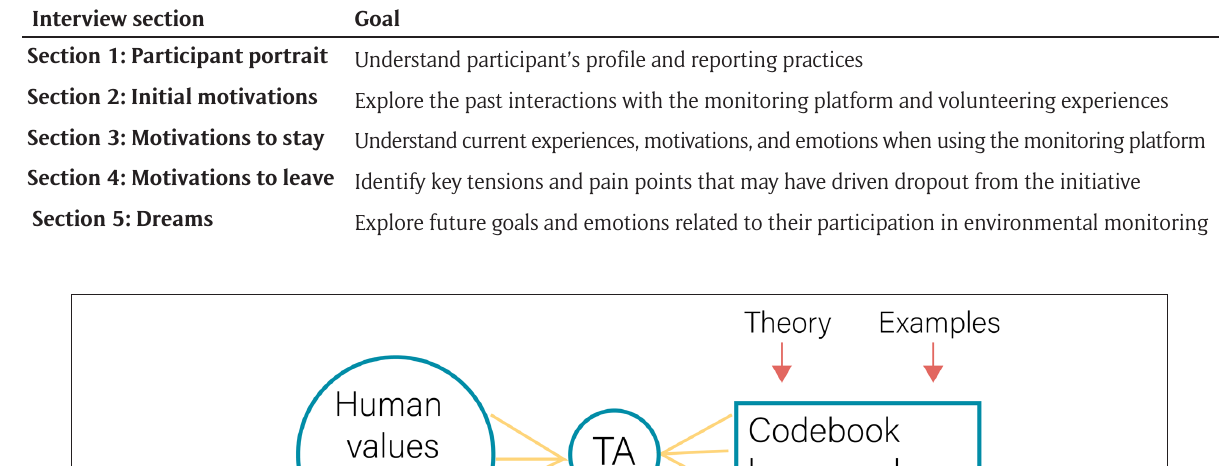
Table 4: Interview design: sections and goals.